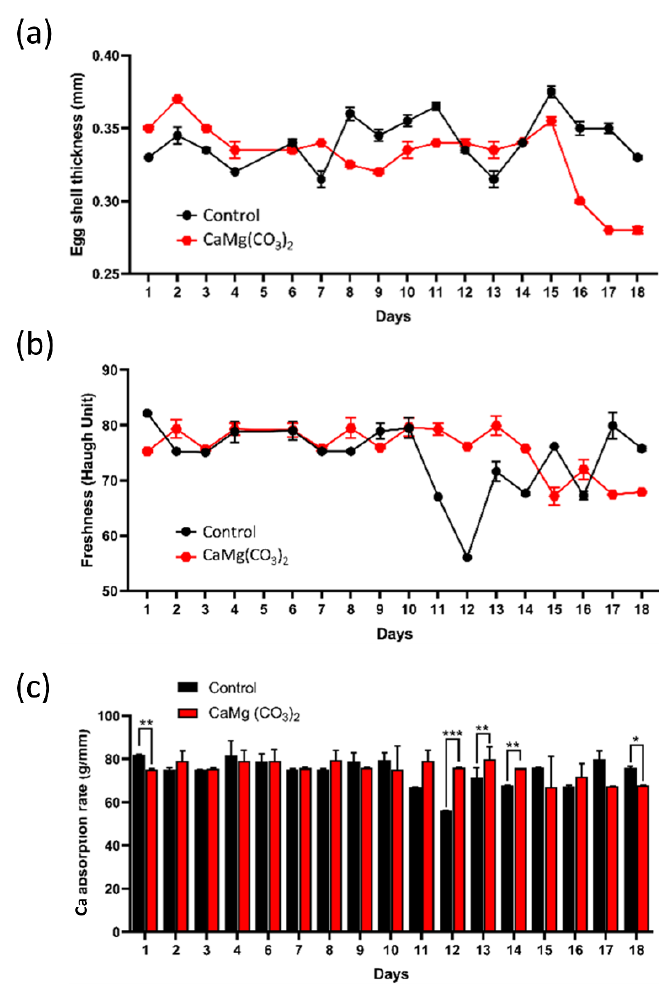
Figure 4. ( a ) The eggshell thickness with respect to the days in control and treated groups. ( b ) The egg freshness measured in the control and experimental group, up to 18 days. ( c ) The calcium absorption rate in control and CaMg(CO 3 ) 2 -treated groups. The significance was calculated using Microsoft Excel (MS Office 365). * p < 0.05, ** p < 0.01, and *** p < 0.001 indicate differences between treatment groups.